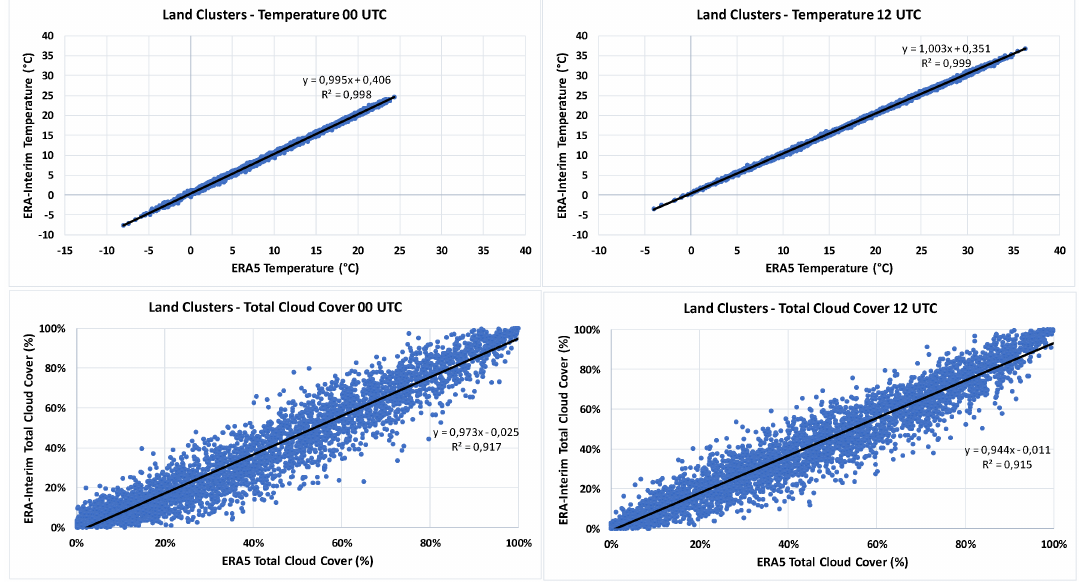
Figure 10. Scatterplots of the spatial mean values of ERA-Interim and ERA5 air temperature and total cloud cover for the areas of clusters 7 and 10–12 (land